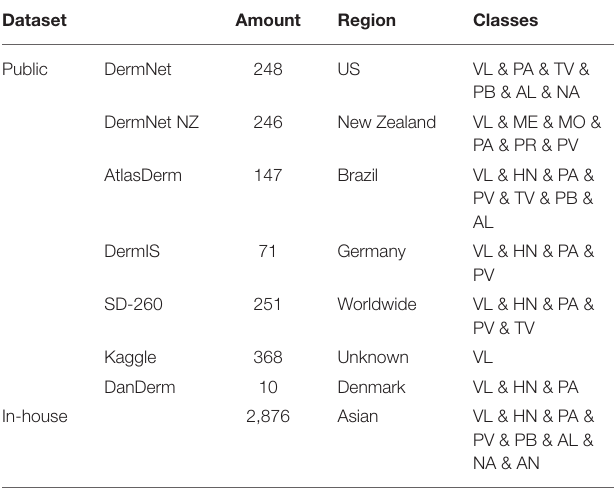
TABLE 1 | Statistical data of the in-house dataset and public